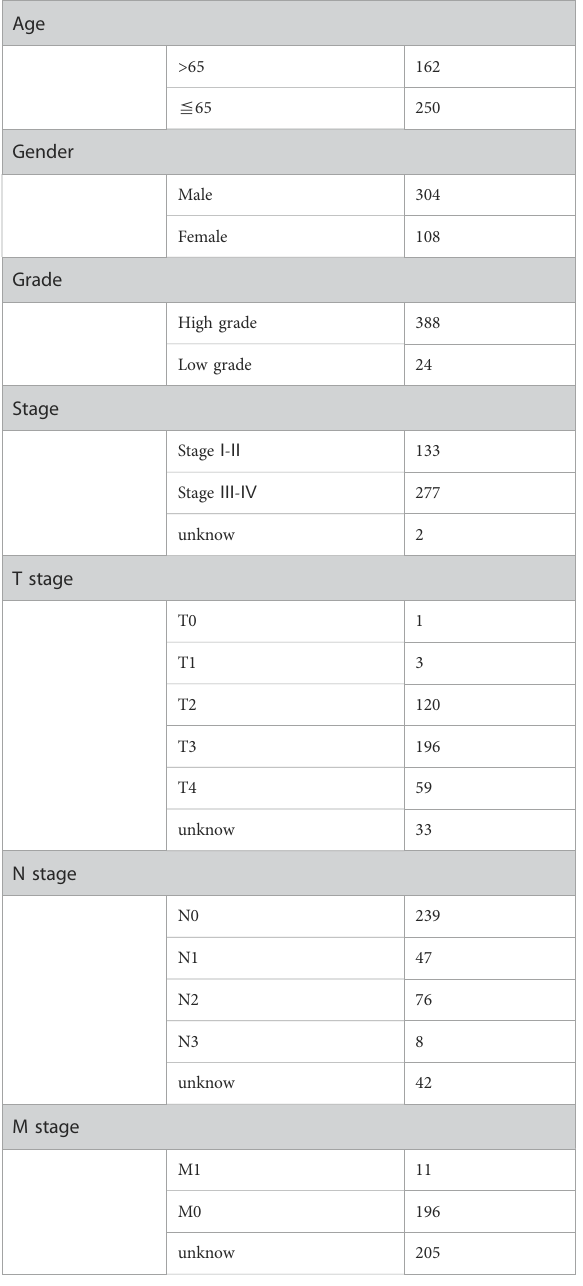
TABLE 1 Clinical features of BC patients in TCGA